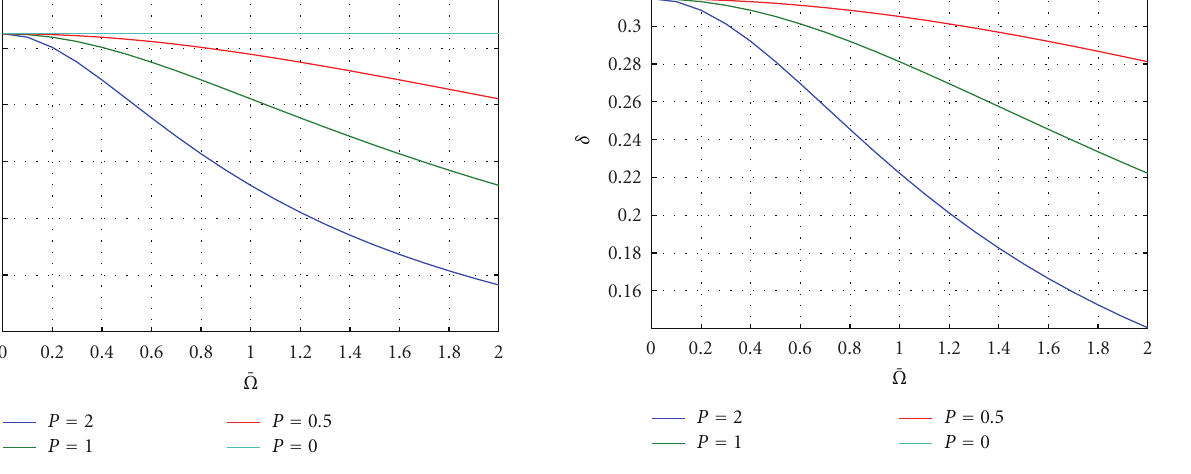
Figure 7: Log decrement as a function of dimensionless running speed, ζ r ,0 = 0 .